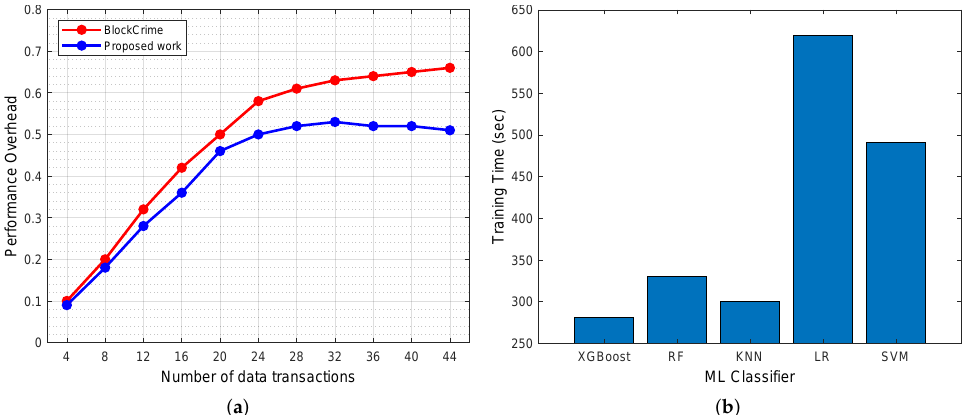
Figure 4. ( a ) Comparison of performance overhead between [63] and proposed work. ( b ) ML classifier training time